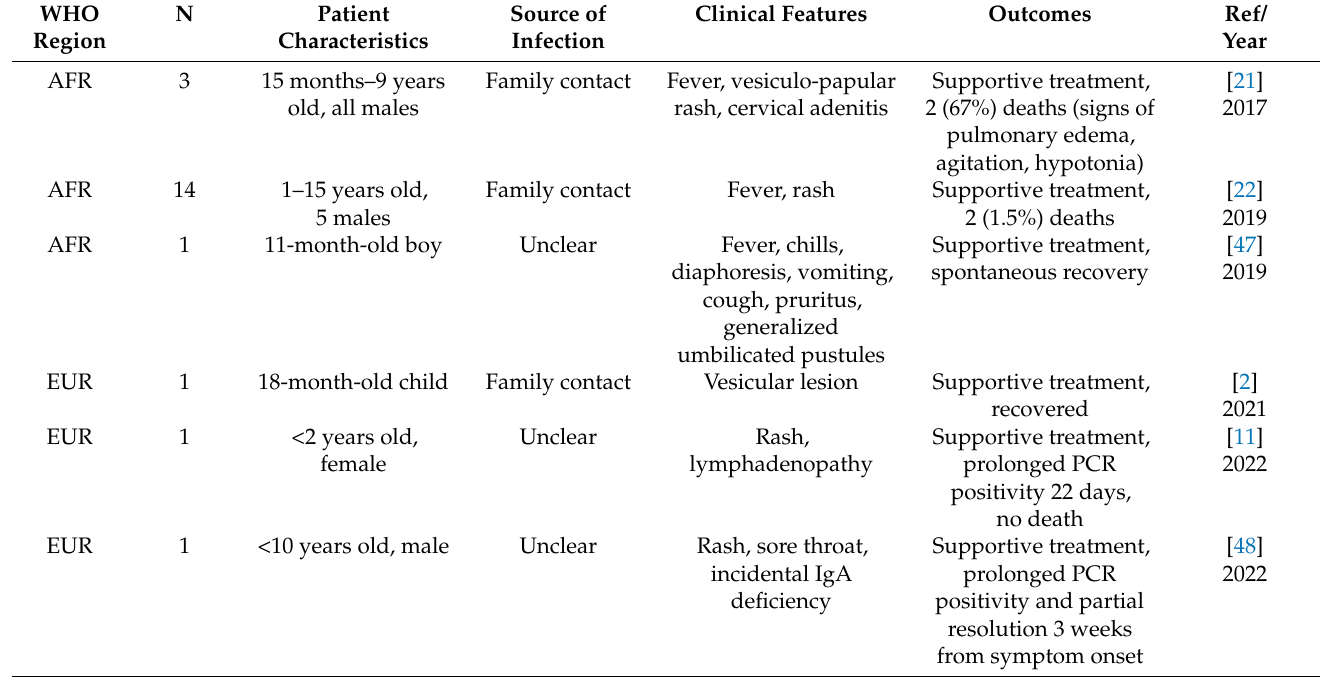
Table 3. Pediatric cases of monkeypox virus infection in humans.